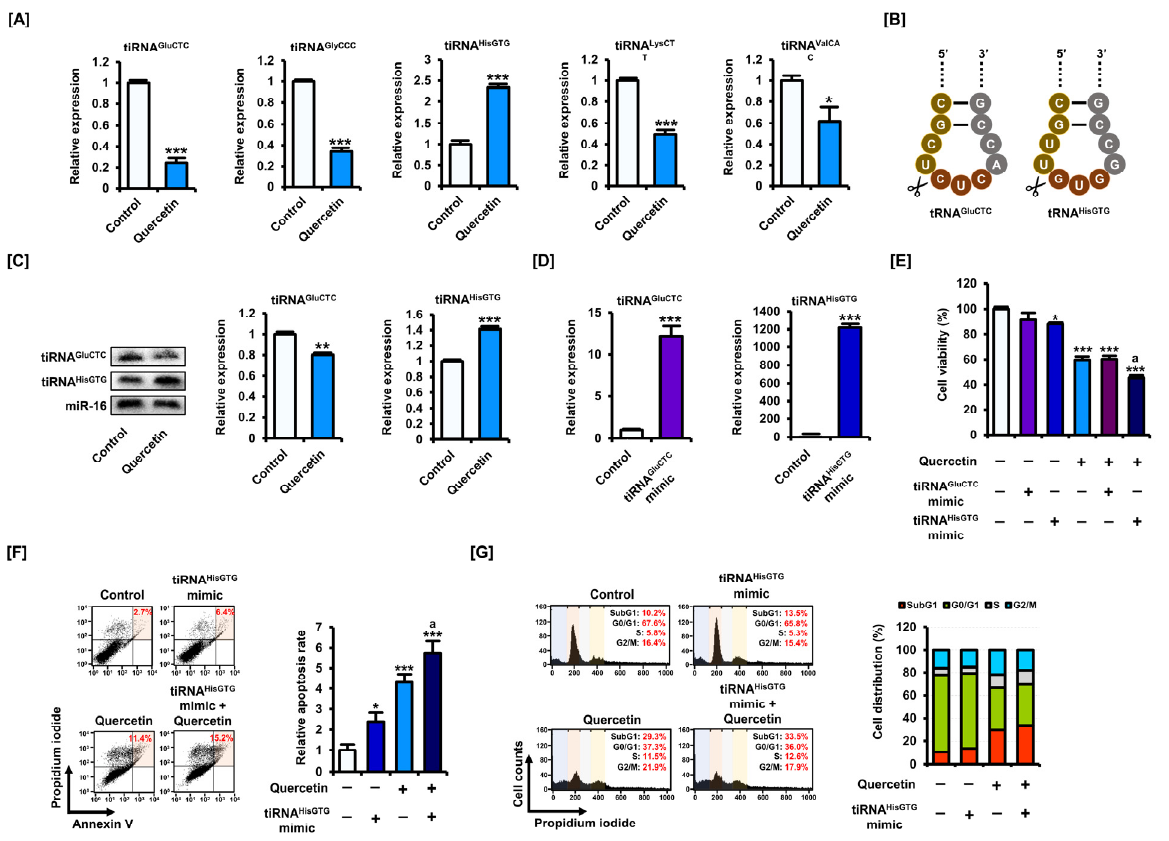
Figure 6. Quercetin regulates the expression of tiRNA in CRC cells. ( A ) Changes in candidate tiRNA expression following quercetin treatment in HCT116 cells were analyzed by qPCR. ( B ) Sequences and cleavage positions in the anticodon loops of tiRNA GluCTC and tiRNA HisGTG . ( C ) Band images of tiRNA GluCTC and tiRNA HisGTG were detected using a DIG probe. Expression of miR-16 was used for normalization. ( D ) After transfection of mimics of tiRNA GluCTC (10 nM) and tiRNA HisGTG (10 nM) into HCT116 cells, increased expression was confirmed by qPCR. ( E ) Cell viability following transfection of mimics of tiRNA GluCTC (10 nM) and tiRNA HisGTG (10 nM) for 5 h and quercetin (40 μ M) treatment was measured in HCT116 cells. ( F ) Apoptotic rates following tiRNA HisGTG (10 nM) transfection for 5 h and quercetin (40 μ M) treatment, as measured by dual Annexin V/propidium iodide (PI) staining and flow cytometry over 48 h. The percentage of cells corresponding to the upper right of the quadrant was used to compare the relative number of apoptotic cells. ( G ) Cell cycle distribution following tiRNA HisGTG (10 nM) transfection for 5 h and quercetin (40 μ M) treatment determined by PI staining and expressed as proportions of cells in sub-G1, G1, S, and G2/M phases over 48 h. Data are presented as representatives of the results of three independent experiments. Asterisks indicate statistically significant differences compared with untreated controls (*** p < 0.001; ** p < 0.01; * p < 0.05). The symbol ‘a’ indicates a significant difference between combination treatment and quercetin treatment alone ( p < 0.05).